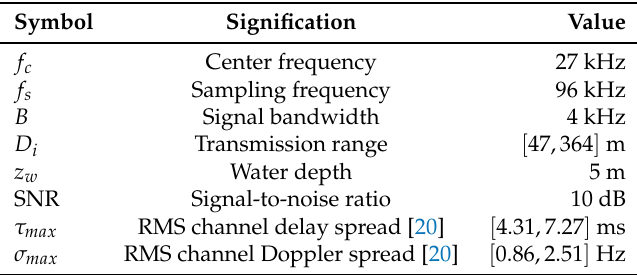
Table 3. Watermark channel